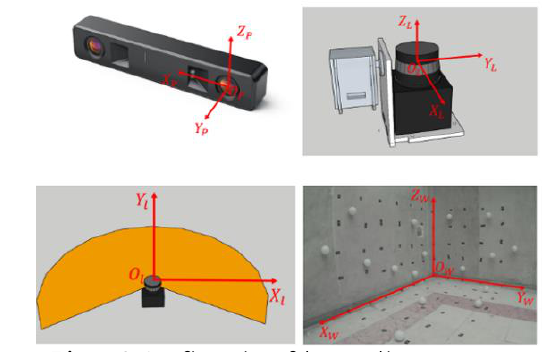
Figure 2. Configuration of the coordinate systems